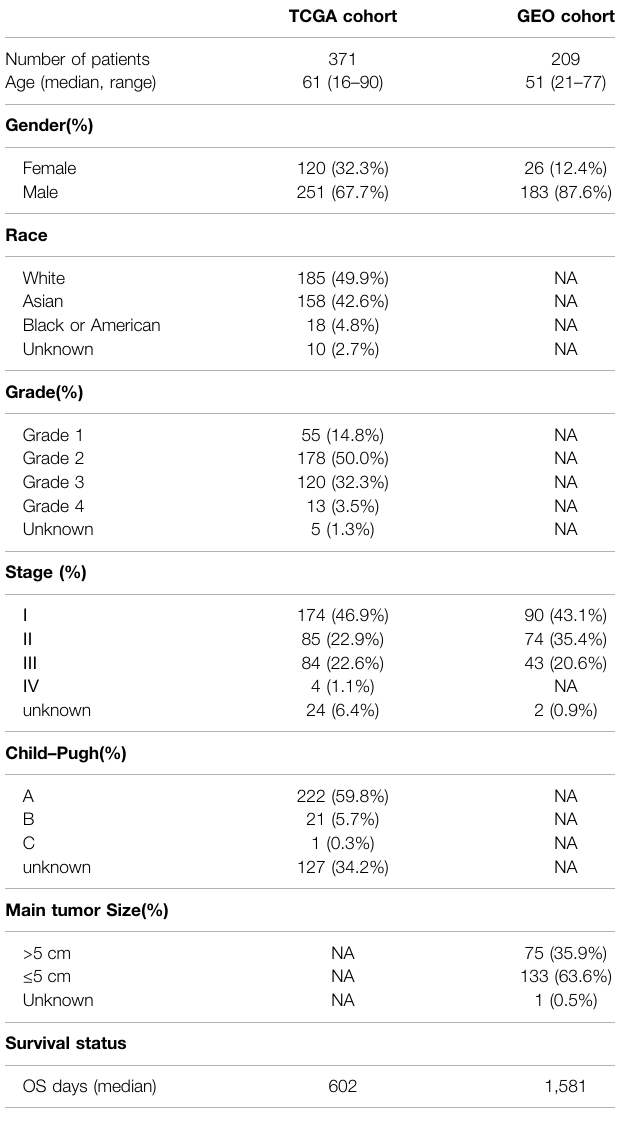
TABLE 1 | Clinical characteristics of the HCC patients used in this